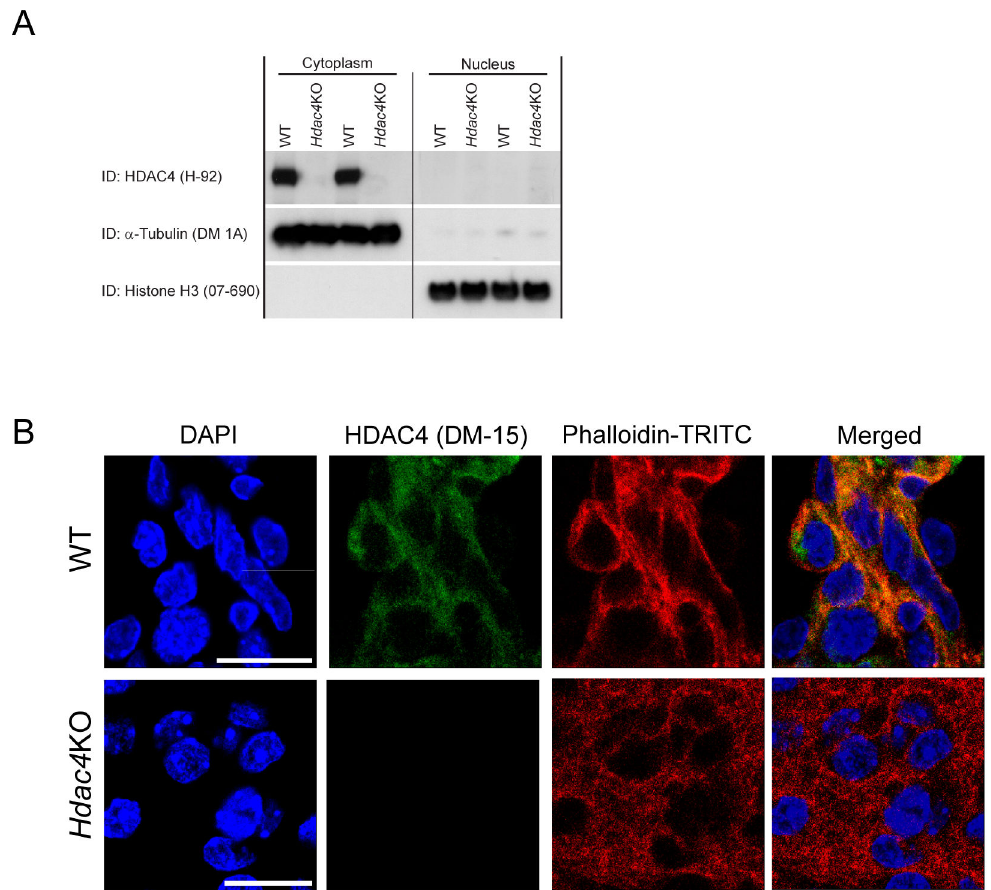
Figure 4. HDAC4 is localised to the cytoplasm in the P3 brain. (A) Western blot showing that HDAC4 is localised exclusively to the cytoplasm and absent in Hdac4 KO brains. (B) Confocal images demonstrating that HDAC4 is localised to the cytoplasm. Scale bar = 25